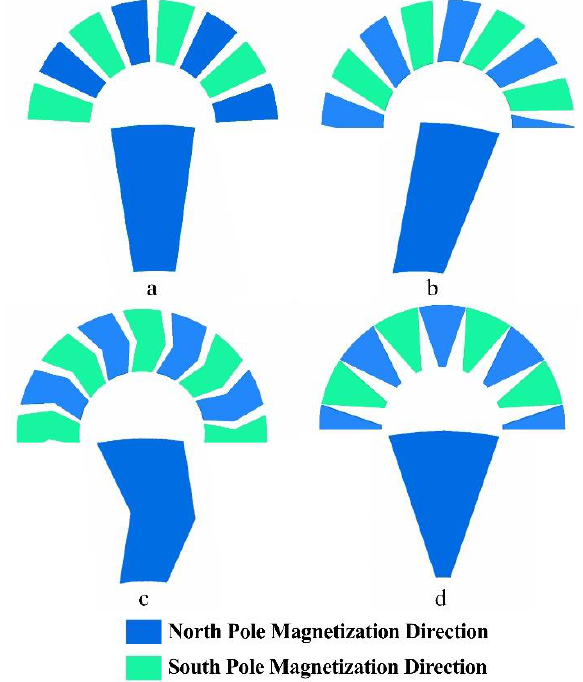
Figure 1. The layout of the permanent magnets and the shape of the magnets as upper and lower, respectively. ( a ) Radial magnets; ( b ) conventional skew magnets; ( c ) dual skew magnets; ( d ) triangular skew magnets.